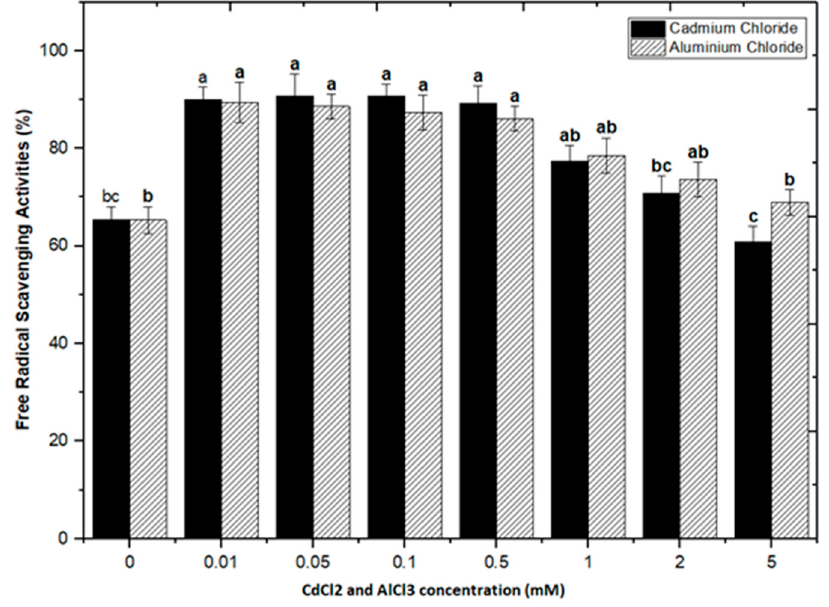
Figure 8. DPPH free radicals scavenging activity of F. indica calli elicited with seven different con- centrations of cadmium chloride and aluminum chloride and control. All the values are mean ± SE. Bars labeled with different letters (LSD values) exhibit significant variation ( α < 0.05).